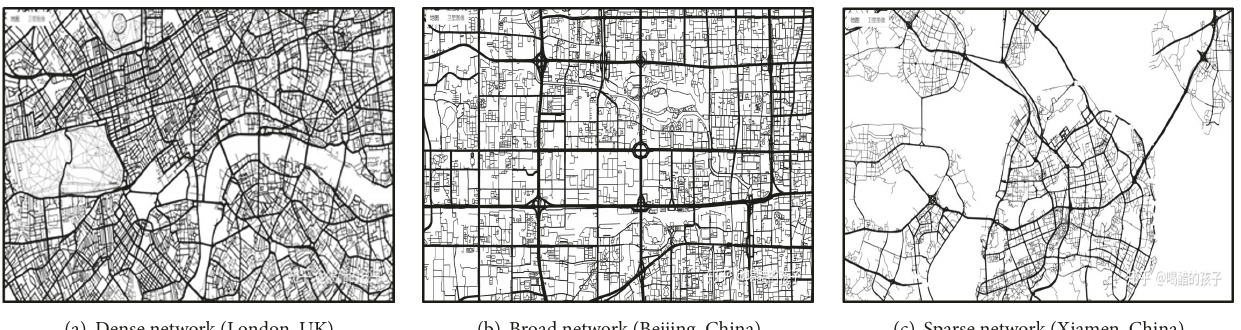
Figure 2: Different types of road network topology.